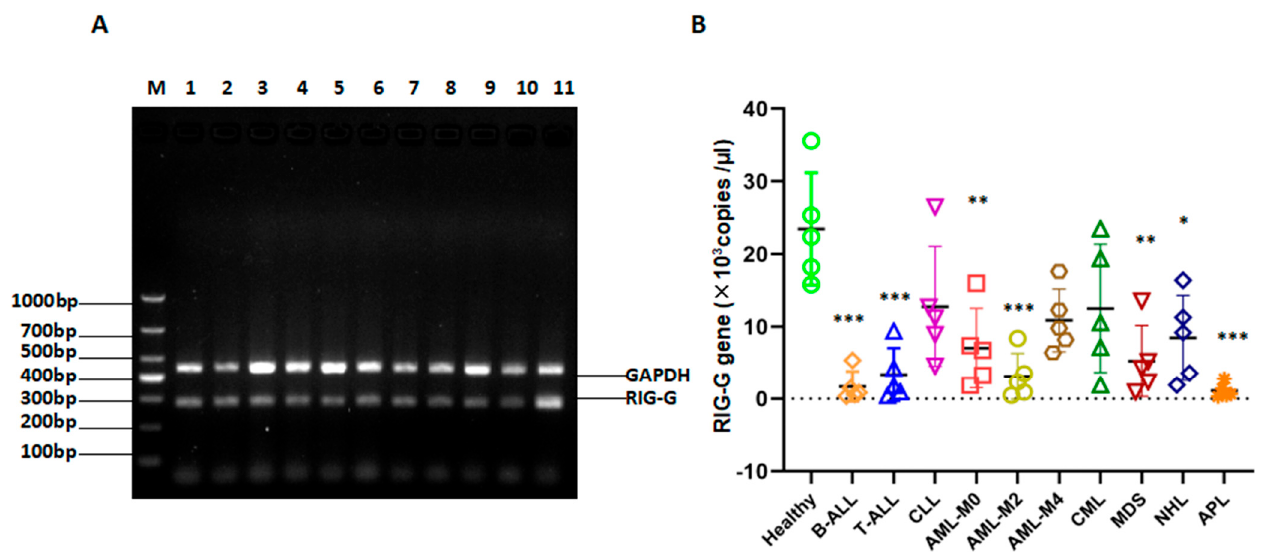
Figure 6. Relationship between RIG-G gene expression in multiple types of leukemia patients. ( A ) Detection PCR amplifi- cation products of RIG-G gene by 2% agarose gel electrophoresis of multiple types of leukemia patients (lane 1 = B-ALL; lane 2 = T-ALL; lane 3 = CLL; lane 4 = AML-M0; lane 5 = AML-M2; lane 6 = AML-M4; lane 7 = CML; lane 8 = MDS; lane 9 = NHL; lane10 = APL; lane11 = healthy control). ( B ) The RIG-G gene expression levels in multiple types of leukemia patients (* p < 0.05, ** p < 0.01, *** p < 0.001).